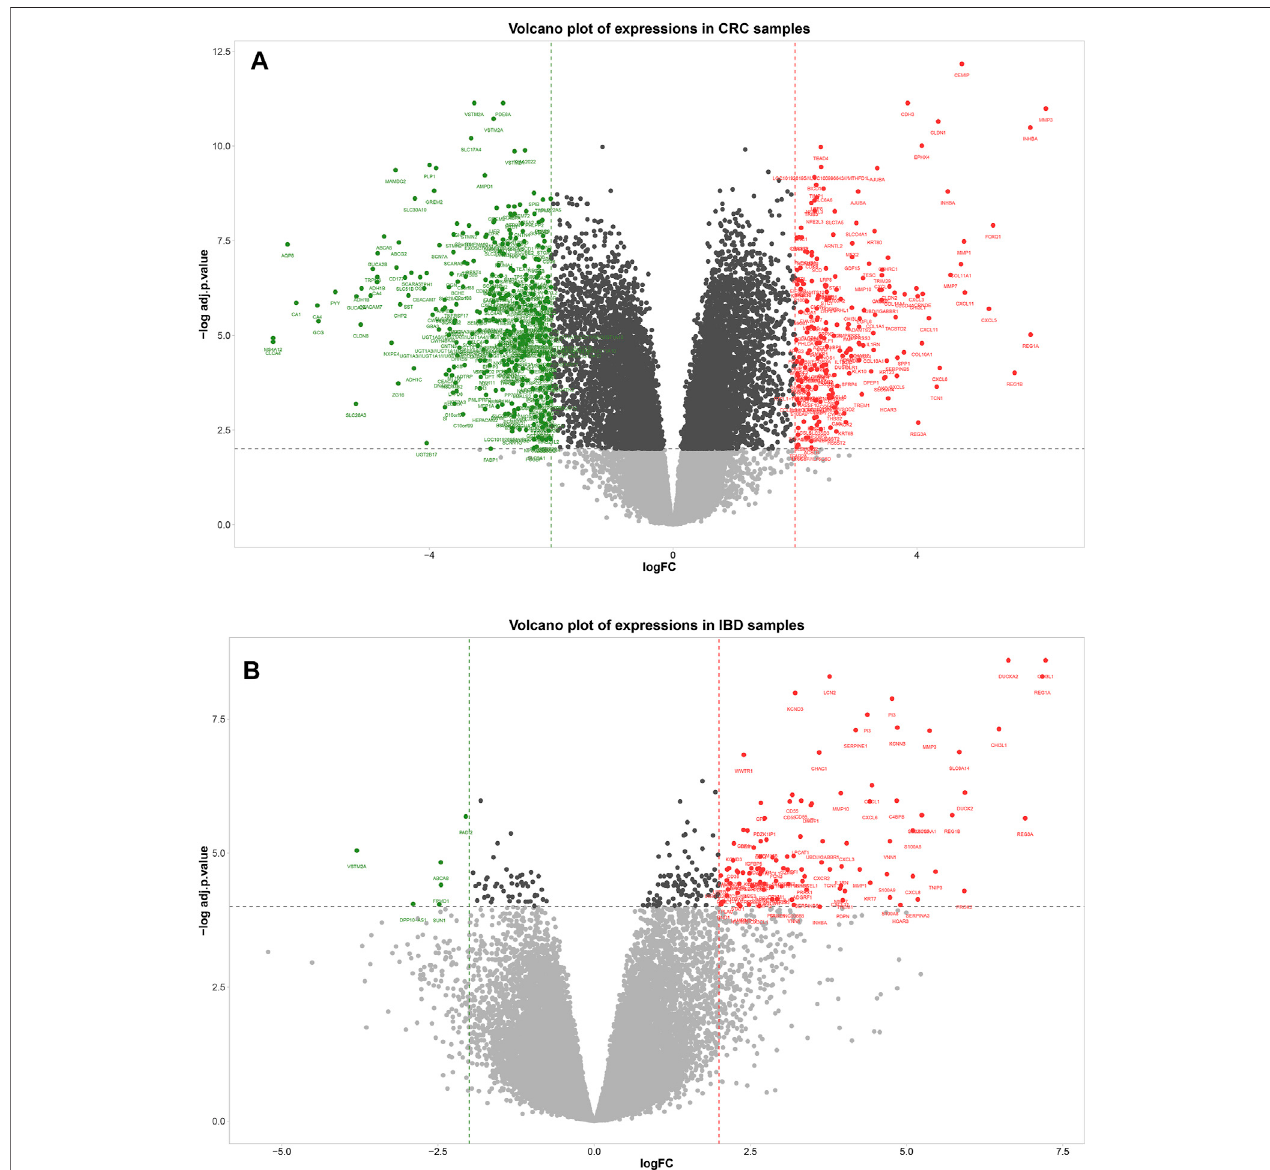
FIGURE 3 | Volcano plot showing differentially expressed genes between tumors normal tissue adjacent to the tumors (A) and IBD and normal samples (B) . In the volcano plot, the vertical axis ( y -axis) is the mean value of -log 10 (adj p -value), and the horizontal axis ( x -axis) represents the value of log(FC). Red dots denote the upregulatedgenes;greendotsrepresentthedown-regulatedgenes.[ (A) :CRCdatasetGSE110224and (B) :IBDdatasetGSE4183].Thecut-offcriteriaforDEGanalysis inCRCdatasetandIBDdatasetweresetas|logFC| ≥ 2,adj. p -value < 0.01,and|logFC| ≥ 2,adj. p -value < 0.0001,respectively.Genesplottedasgreydotsdonot meet these